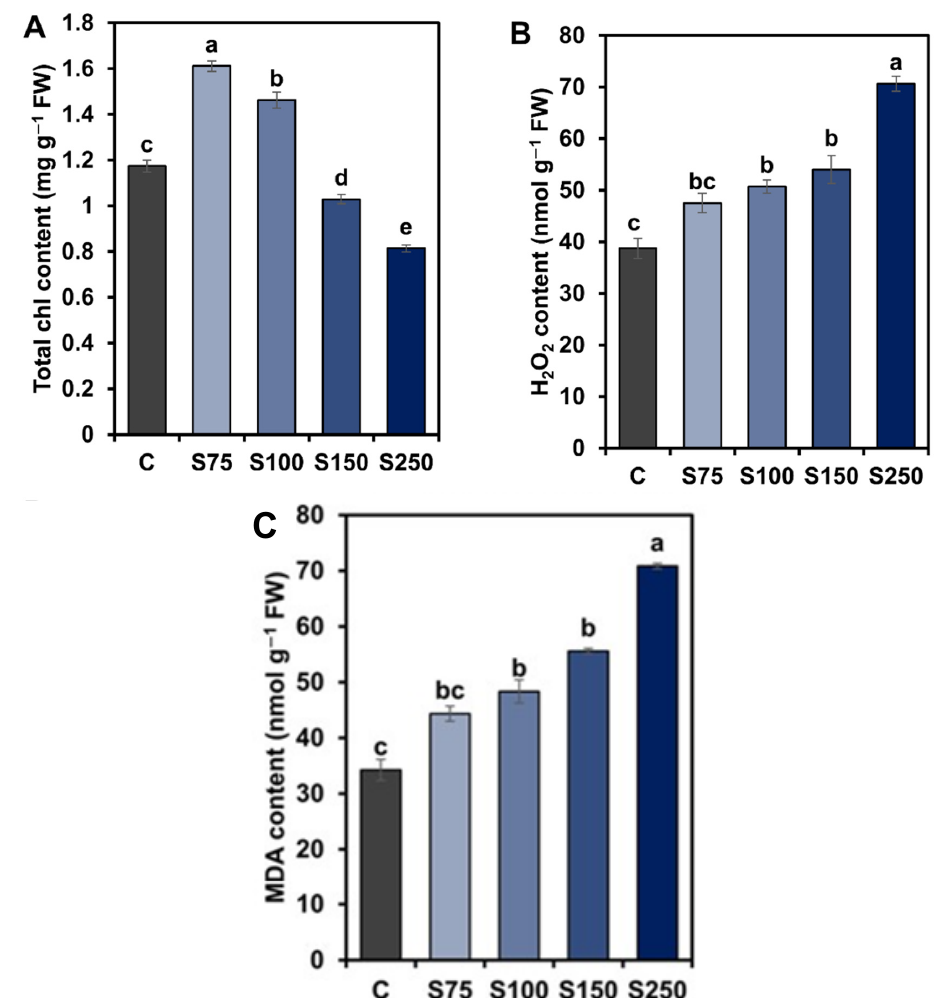
Figure 3. Effects of soil salinity on total chlorophyll (Chl) content ( A ), H 2 O 2 content ( B ), and MDA (malondialdehyde) content ( C ) in sugar beet after exposed to various salt concentrations for 95 days. Each bar represents the average of three independent replicates ( n = 3 ), and the error bar denotes standard errors. Statistically significant differences among different treatments are designated by various alphabetic letters based on Tukey's honestly significant differences test ( P < 0.05 ). Control (C), 0 mM NaCl; S75, 75 mM NaCl; S100, 100 mM NaCl; S150, 150 mM NaCl; S250, 250 mM